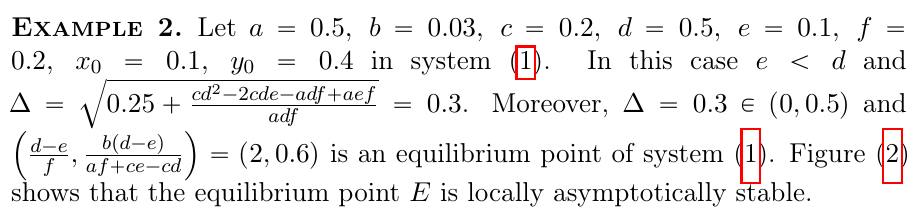
Fig. 1. Plot of system x n ` 1 “ 0 . 35 y n